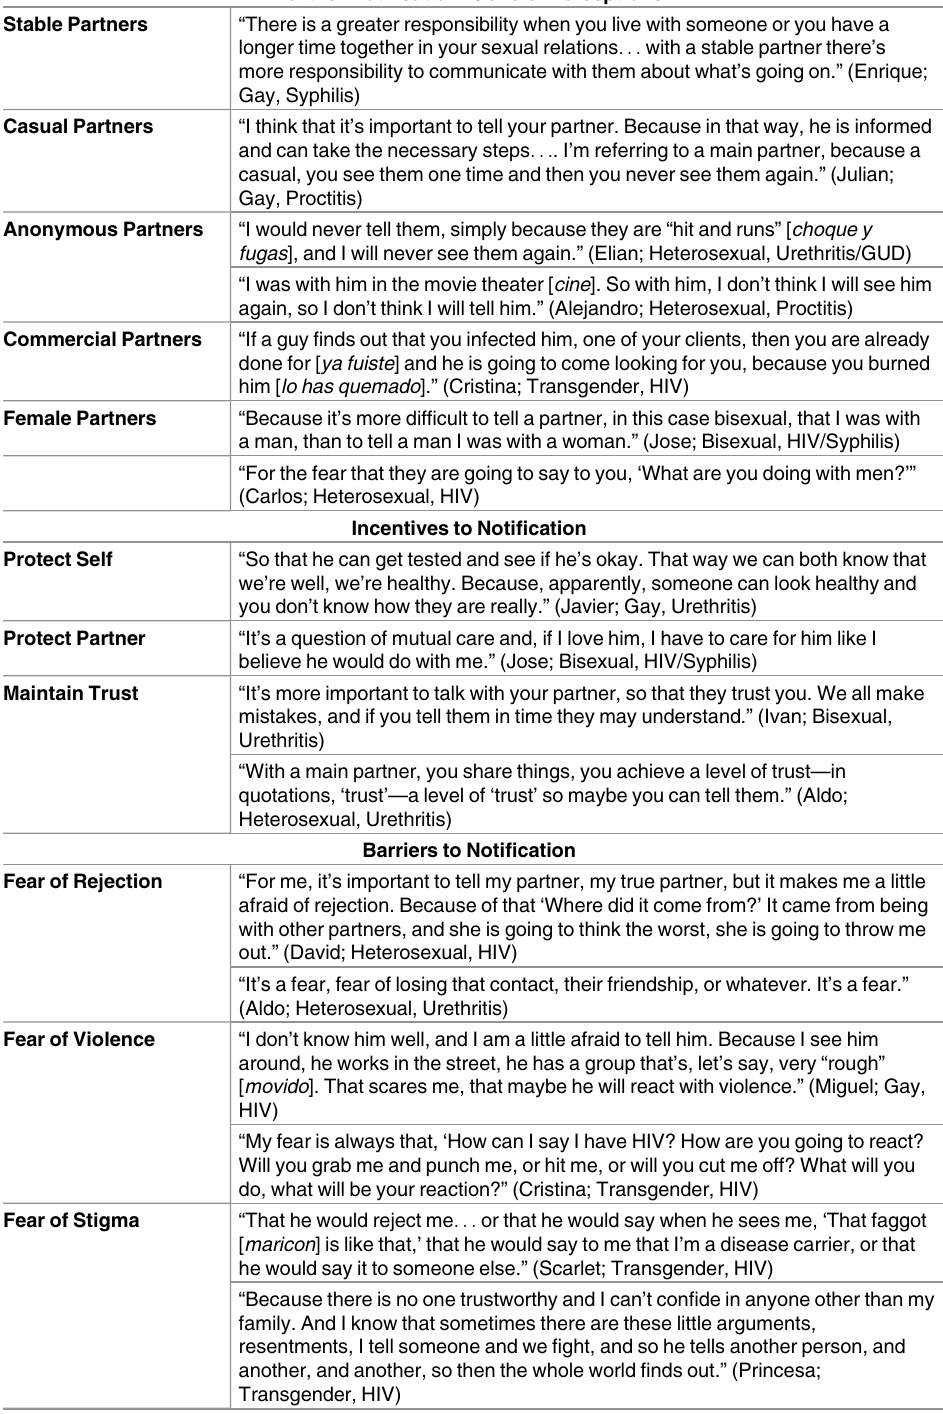
Table 4. Qualitative Analysis of Perceptions, Incentives, and Barriers to Partner Notification Among MSM/TW Recently Diagnosed with HIV/STI; Lima, Peru